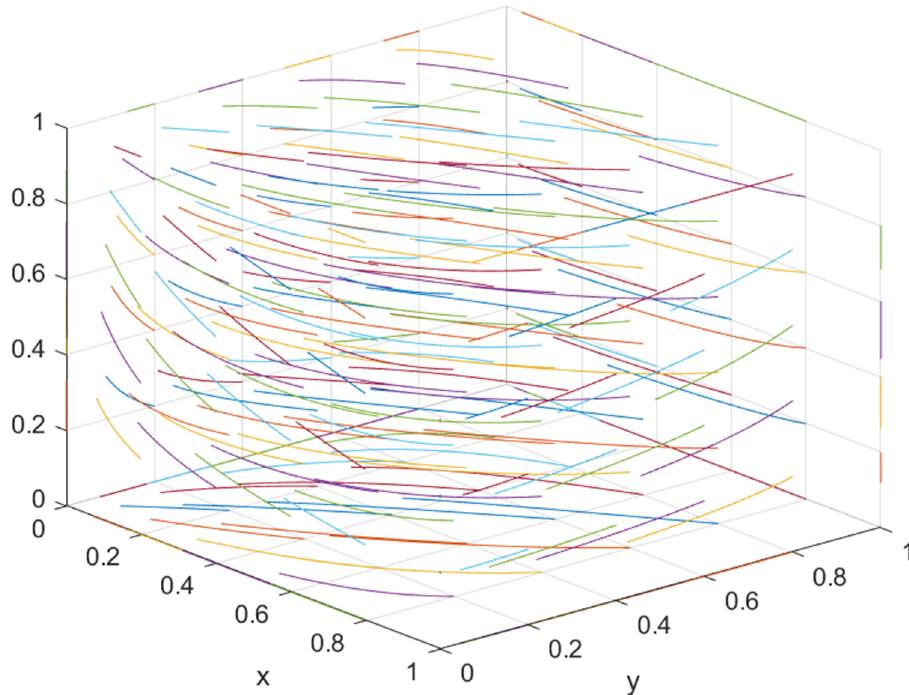
Figure 2. A4 = (0, 0, 1) evolution result.